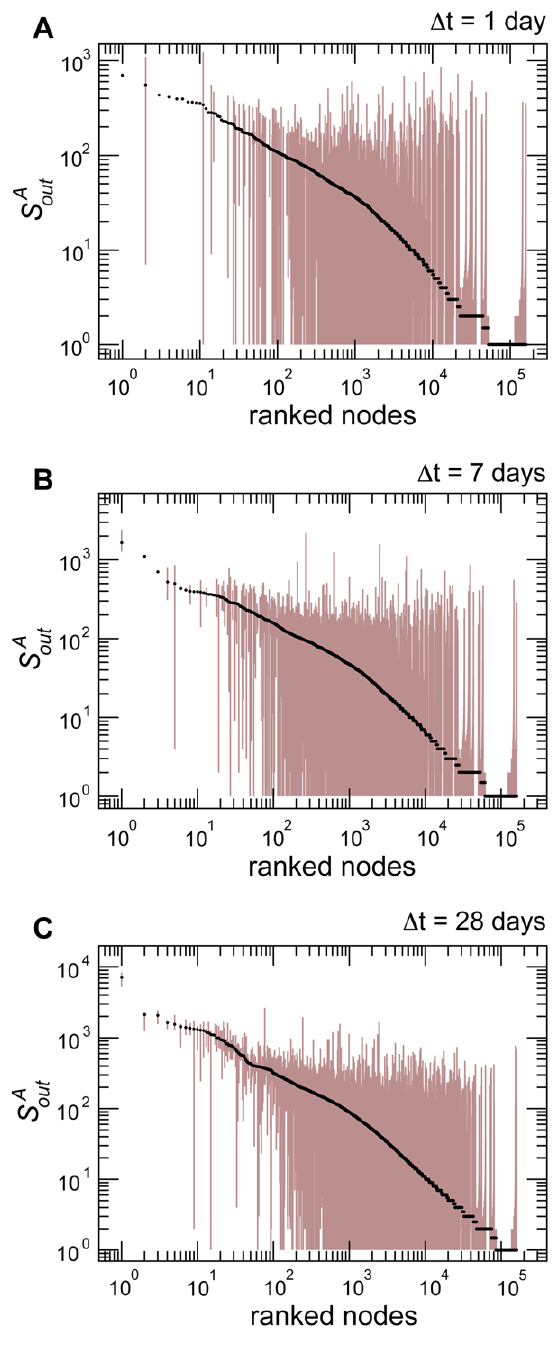
Figure 9. Fluctuations of the total outgoing traffic of bovines of a given holding for various aggregating time windows. The plot shows, for each holding of the system, the fluctuations of the assumed by each node during all snapshots of the D t values of s A out under study. The median (black dots) and the 95% confidence interval (brown shaded area) of outgoing traffic are shown.